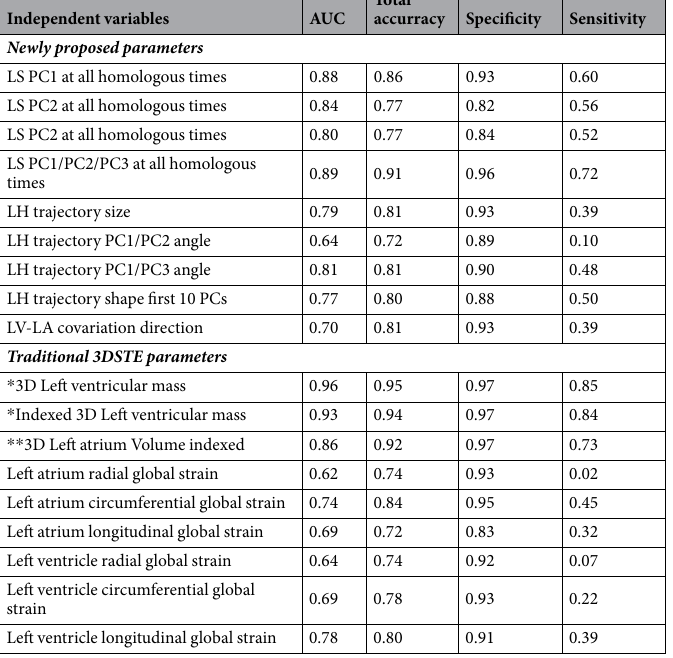
Table 1. Classification performance of new and traditional indicators according to randomized SVM. Asterisk indicates that circular reasoning affects corresponding results. Double asterisk indicates a size-associated